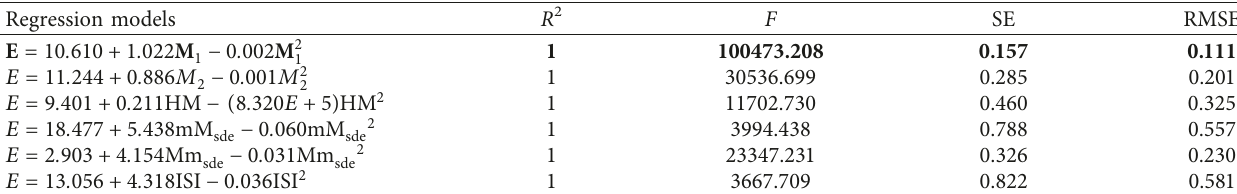
Table 7: The quadratic regression models that give the best estimate for the enthalpy of vaporization (E). Regression models